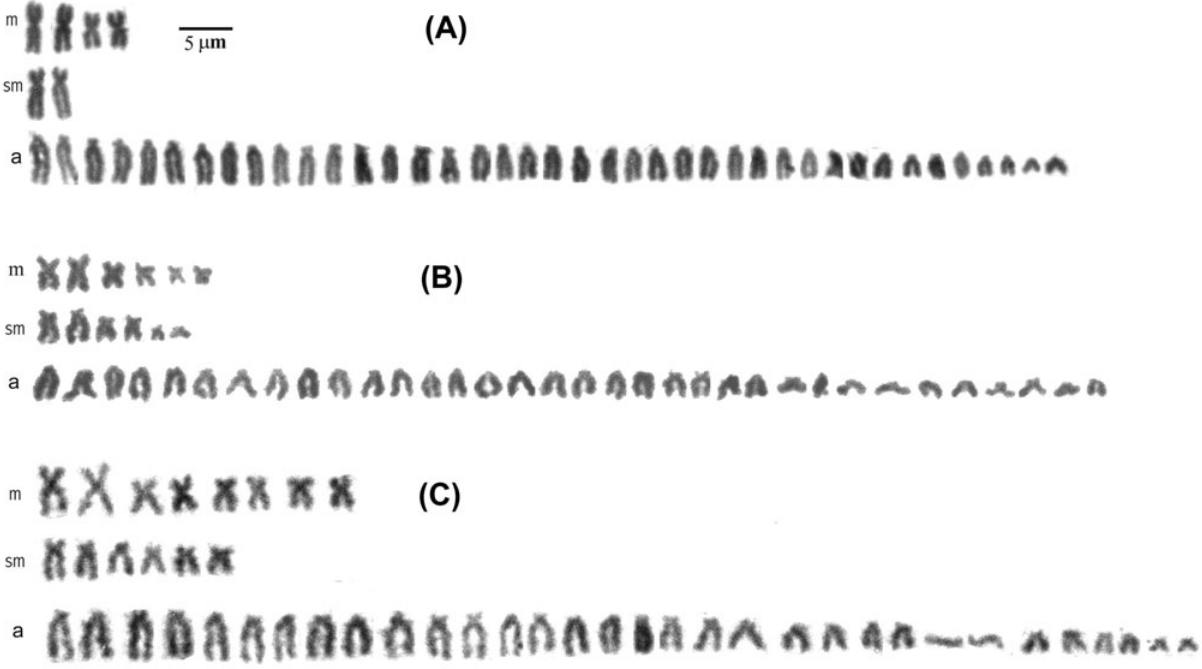
Fig. 1. – Standard karyotypes of Amphichthys cryptocentrus (A), Batrachoides manglae (B) and Thalassophryne maculosa (C). Abbreviations: m, metacentric; sm, submetacentric, and a,